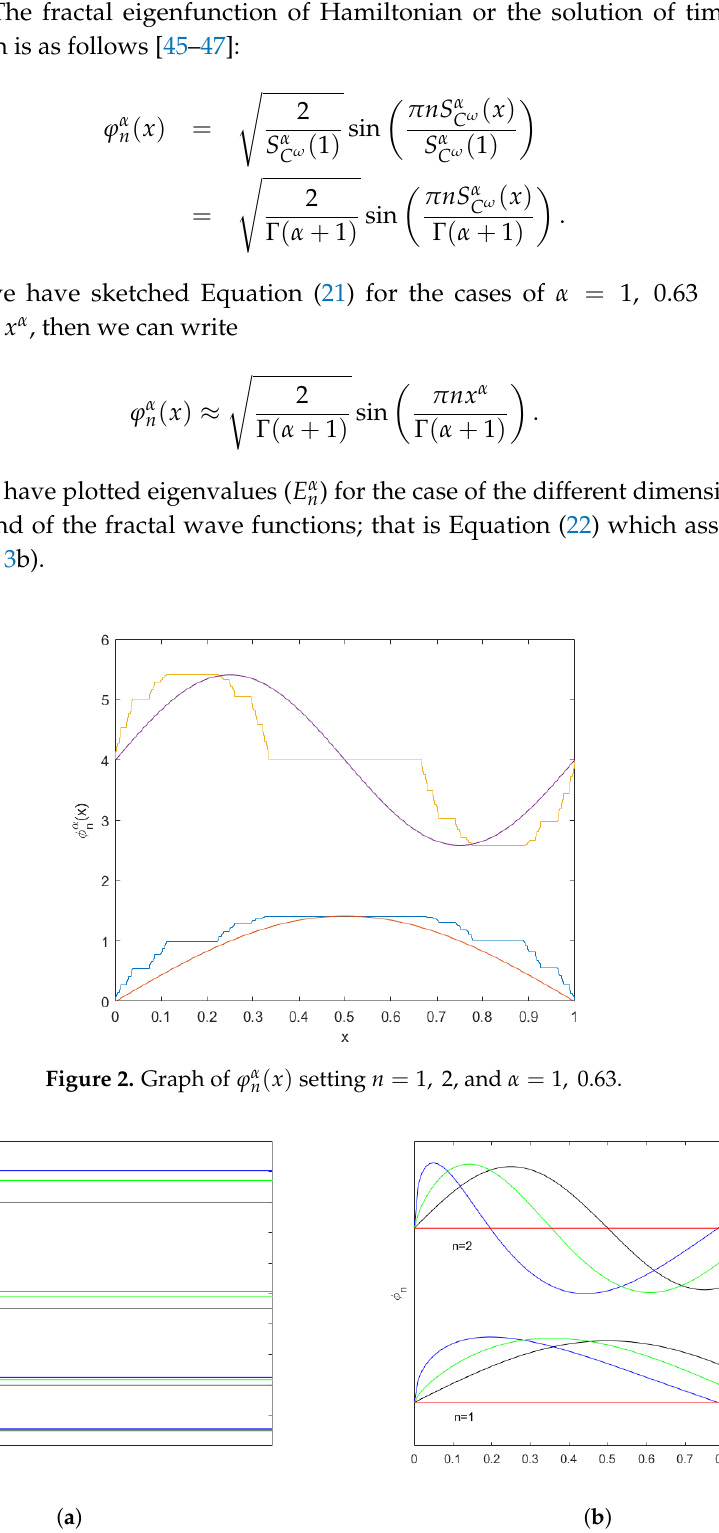
Figure 3. Graph of the solutions of the Schrödinger equation on fractal space and their eigenvalues. ( a ) Energy levels verses by space dimension, α = 1 (black), α = 0.5 (blue), α = 0.75 (green); ( b ) Upper bound of the fractal wave function corresponding to space dimension, α = 1 (black), α = 0.5 (blue), α = 0.75